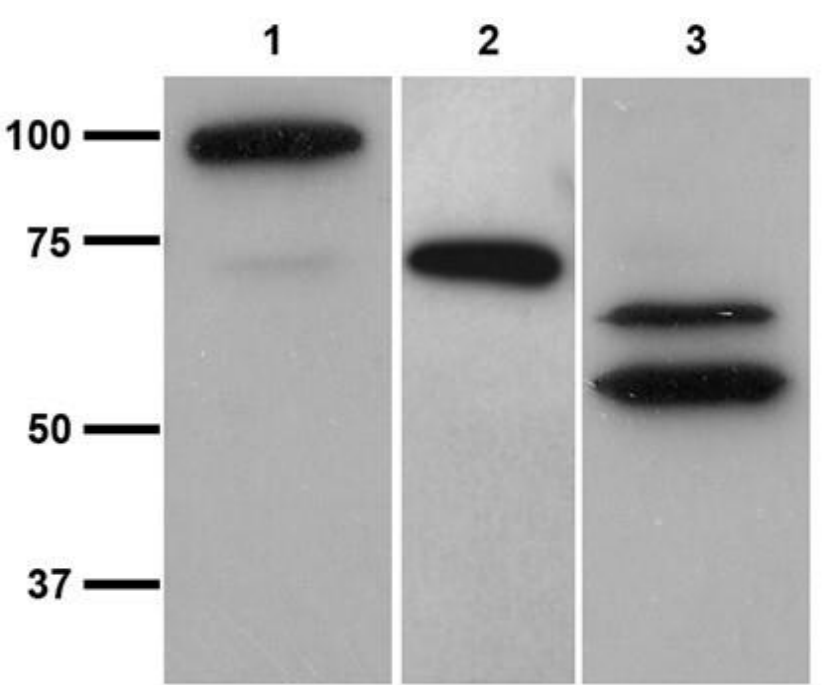
Figure 5. 10% SDS-PAGE electrophoresis and immunoblotting of L. infantum promastigotes lysates using transglutaminase polyclonal antibodies (orb2986), HRP-conjugated Goat anti-Rabbit (H + L) secondary antibodies, and ECL detection system. Lane 1, purified guinea pig TGase; lane 2, IZSLER_MO1 L. infantum extract; and lane 3, MHOM/TN80/IPT1 L. infantum extract. (please find the WB full membrane in Figure